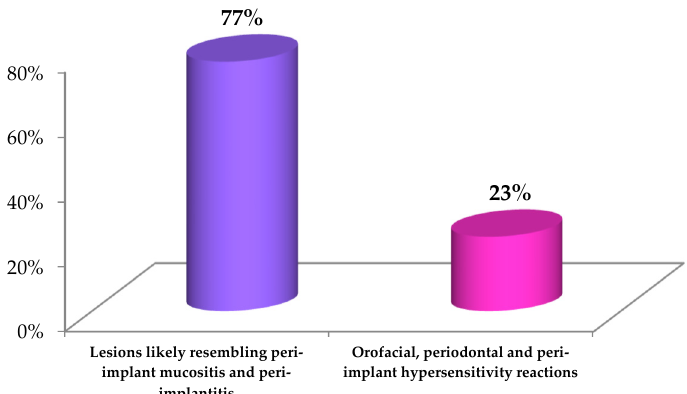
Figure 4. Frequency of Titanium allergy in relation to the described lesions, categorized as those likely resembling peri-implant mucositis and peri-implantitis, reactive lesions of the peri-implant mucosa, and orofacial, periodontal, and peri-implant hypersensitivity reactions.